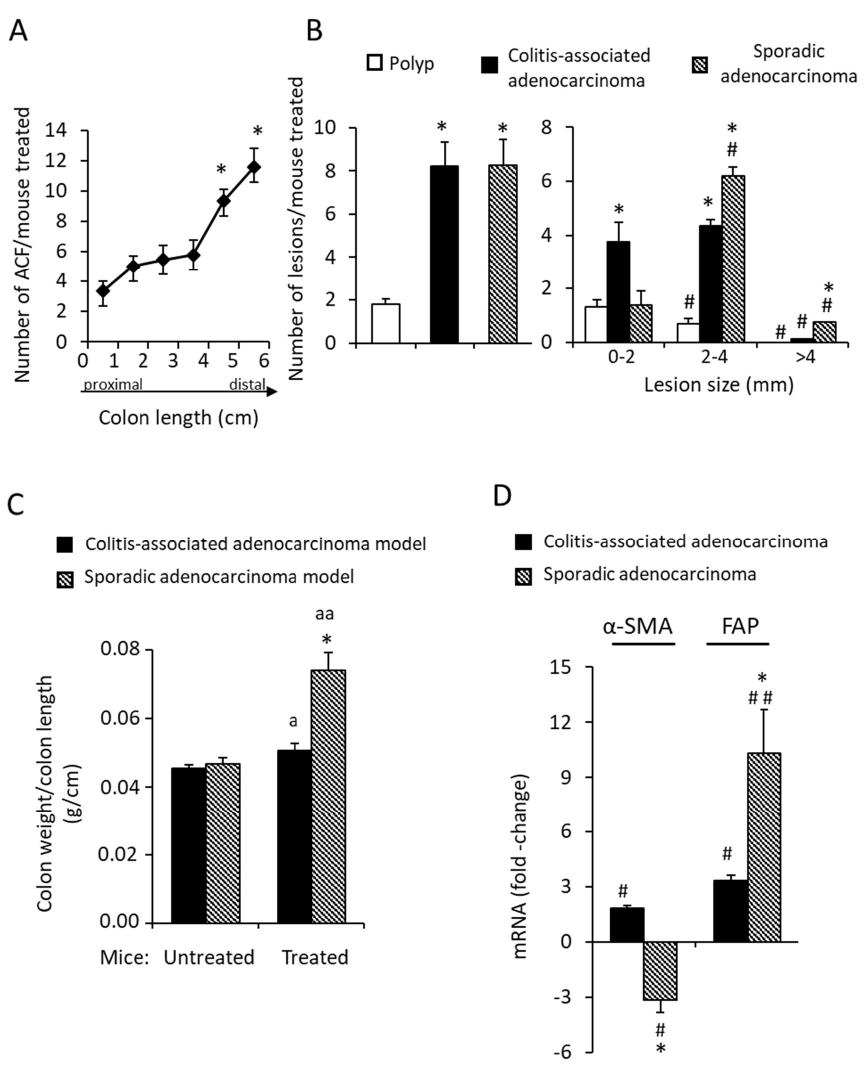
Figure 2. Characterization of colon lesions in the mouse models. ( A ) Number of aberrant crypt foci (ACF) per mouse observed along the colon: 0–2 cm corresponds to proximal colon, 3–4 cm to prox- imal–distal colon region and 5–6 cm to distal colon. ( B ) Number of lesions per mouse in the different models and sorted by size. ( C ) Ratio of colon weight/colon length expressed in g/cm. ( D ) α-SMA and FAP mRNA abundance in colon sporadic adenocarcinomas and colitis-associated adenocarcinomas expressed as fold change relative to control (untreated) mouse colons. Data are means ± SEM ( n = 8– 10 animals per group). ANOVA shows the effect ( p < 0.0001) of the colon region on the number of ACF (in ( A )); the type of pathology on the number and size of lesions (in ( B )); and the type of adenocarci- noma on the ratio colon weight/colon length (in ( C )) and the α-SMA and FAP mRNA abundances (in ( D )). Tukey’s test: * p < 0.001 vs. 1 centimeter (in ( A )); * p <0.001 vs. polyps; # p <0.001 vs. 0–2 mm lesions (in ( B )); a p < 0.05, aa p < 0.001 vs. control mice and * p < 0.001 vs. colitis-associated adenocarcinomas (in ( C )); # p < 0.05, ## p < 0.001 vs control mice and * p < 0.001 vs. colitis-associated adenocarcinomas (in ( D )).